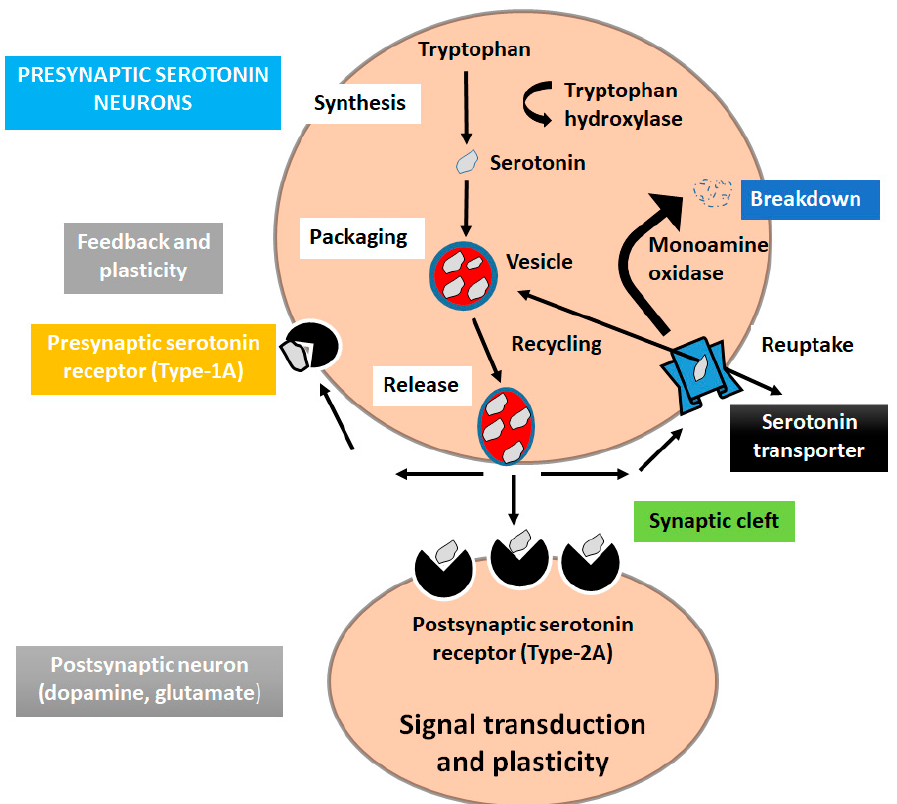
Figure 4. Serotonin signaling pathway in depression. The amino acid tryptophan is converted into 5HTP, and the 5HTP is converted into 5HT.